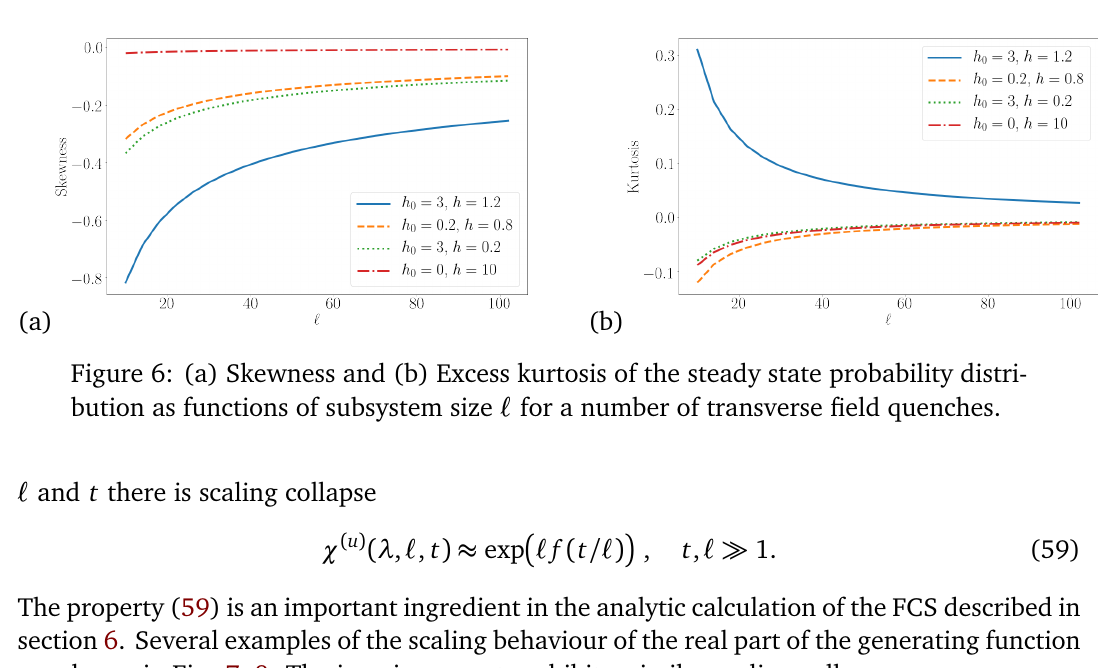
Figure 5: Stationary state probability distribution P ( u ) (cid:96) = 70 for several transverse field quenches.